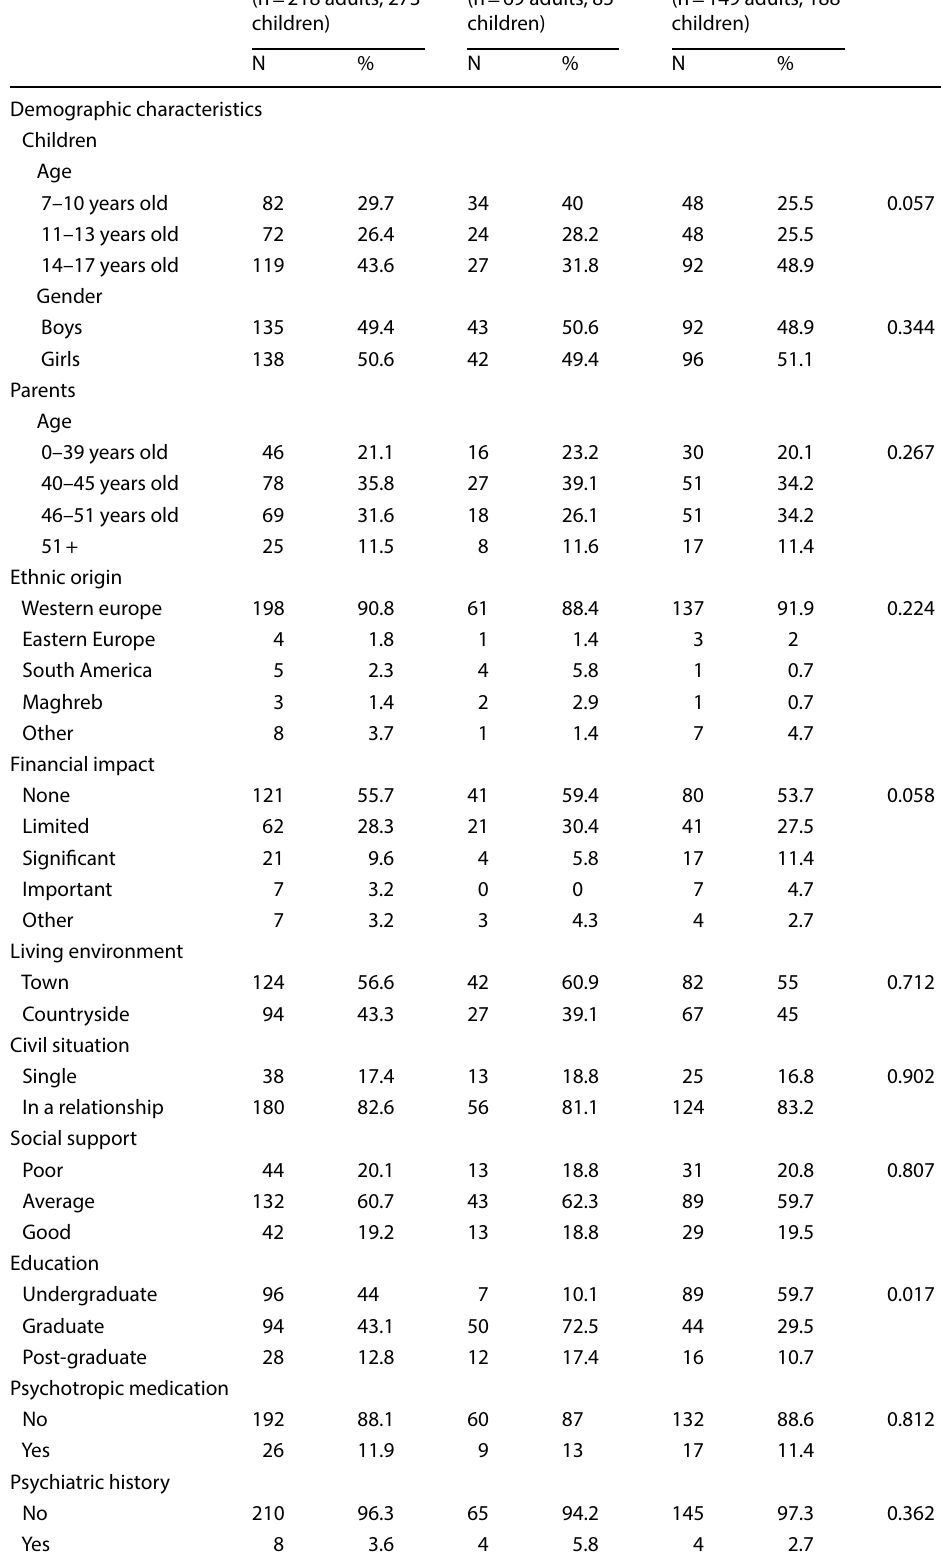
Table 1 Socio-demographic characteristics of